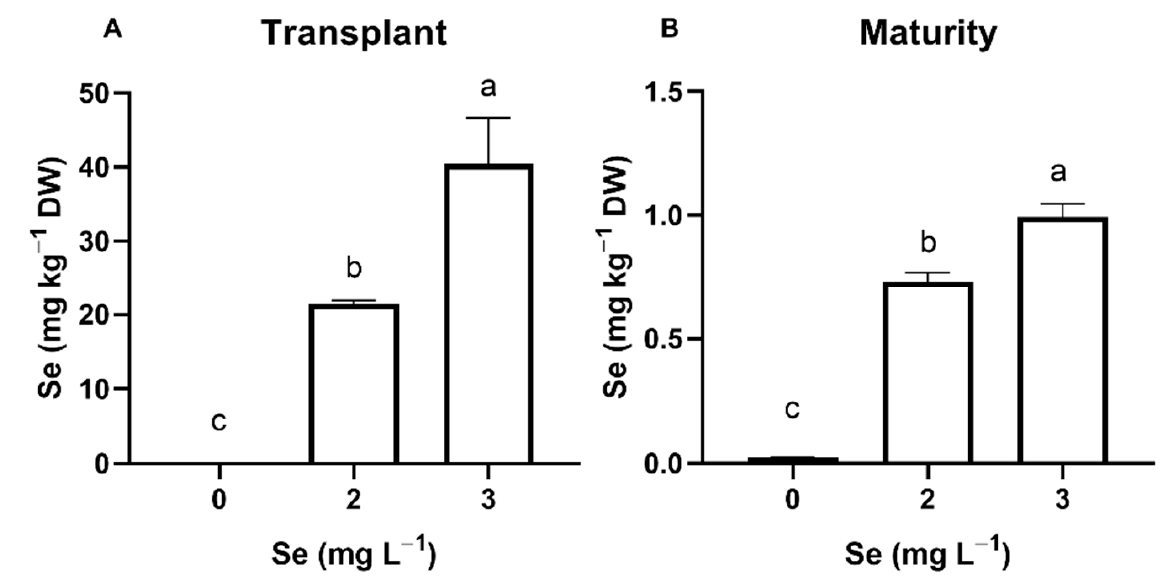
Figure 7. Selenium (Se) content of basil plants, measured at transplant ( A ) and maturity ( B ), treated with different concentrations of Se at pre-transplanting. Means ( n = 3) flanked by different letter are statistically different for p = 0.05 after Tukey’s test.